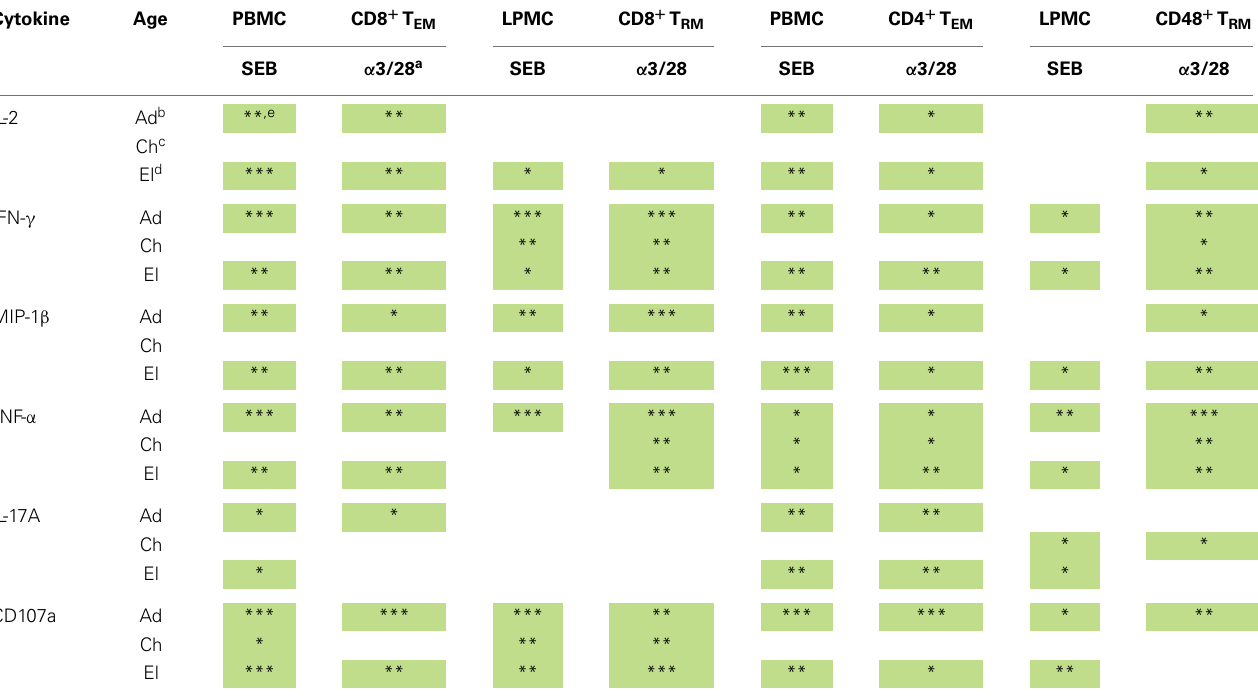
Table 4 | Summary ofT RM andT EM responses to stimulation in children, elderly, and adults . Cytokine